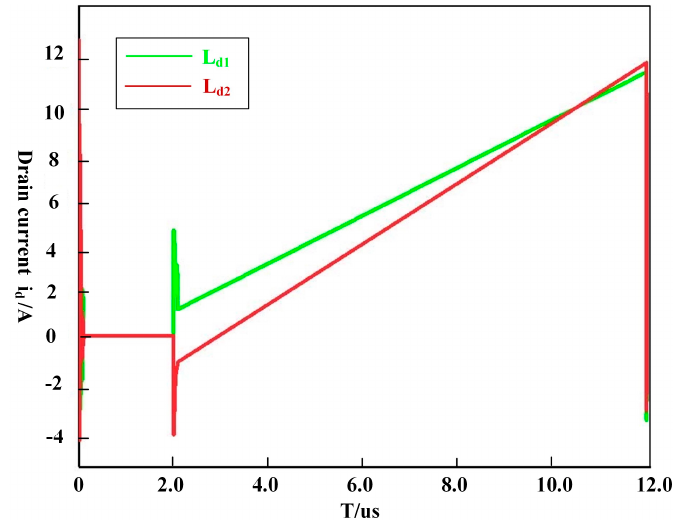
Figure 9. Simulation curves of i d and L d1 /L d2 .